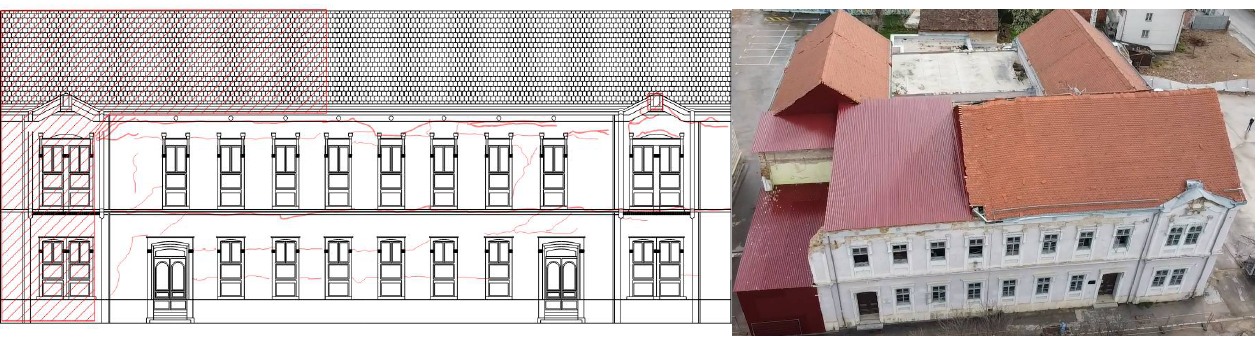
Figure 9. Southwestern façade plan with marked damage.